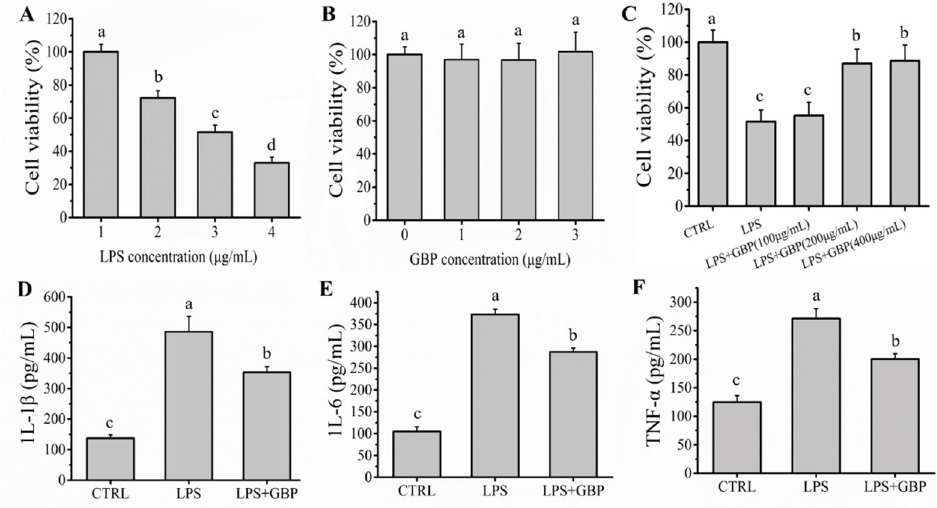
Figure 1. ( A ) The viability of RAW264.7 macrophages with different concentrations of LPS treatment; ( B ) The viability of RAW264.7 macrophages with different concentrations of GBP treatment; ( C ) Effects of the different concentrations of GBP pre-treatment on LPS-mediated RAW264.7 macrophages viability (LPS concentration: 3.0 µ g/mL, GBP concentration: 100, 200 and 400 µ g/mL); ( D – F ) Effects of the GBP pre-treatment on the levels of IL-1 β , IL-6 and TNF- α on model of LPS-mediated RAW264.7 macrophages damage. Different letters (a, b, c and d) in the figure represent significant differences between groups ( p < 0.05).